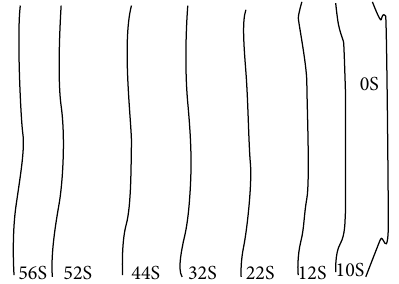
Figure 6: Imaging of grain end at each di ff erent moment of Test2.